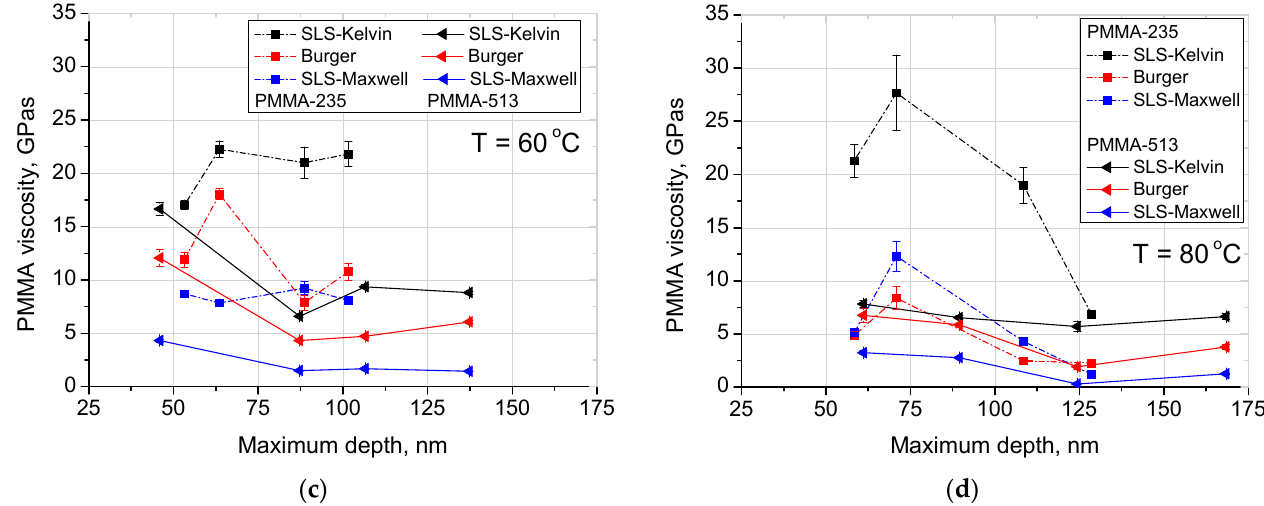
Figure 4. Analysis of PMMA viscosity obtained by: Burger model ( η ), SLS-Maxwell model ( η 1 ) and SLS-Kelvin model ( η 1 ): ( a ) viscosity at 20 °C; ( b ) viscosity at 40 °C; ( c ) viscosity at 60 °C, ( d ) viscosity at 80 °C. Lines are just guides for the eyes. To take into account, the effect of the substrate, King’s method of correcting measured Young’s modulus was used in Equation (1) [29]. This was used for Oliver and Pharr (OP)